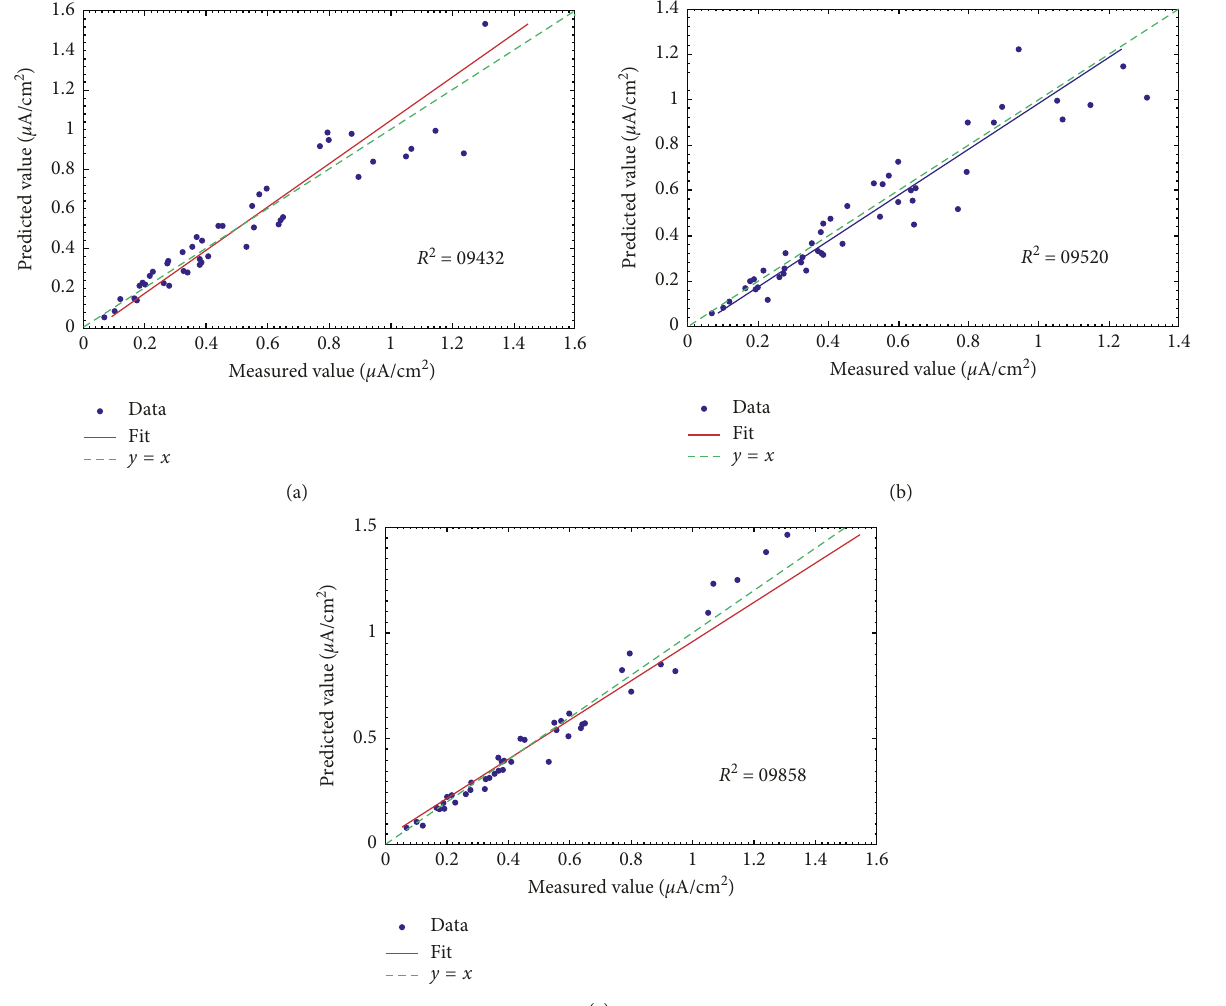
Figure 12: Regression lines between measured values and predicted values of three algorithms. (a) BPNN model; (b) PSO-NN model; (c) QPSO-NN model.